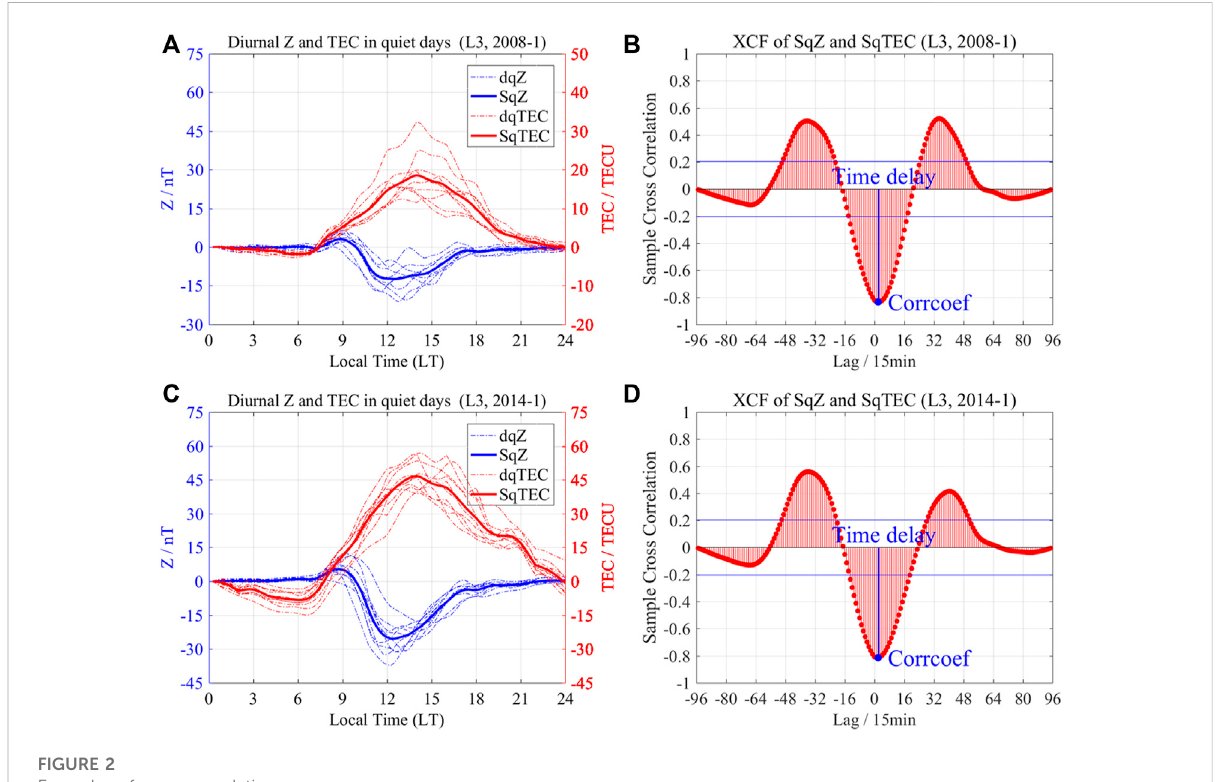
FIGURE 2 Examples of